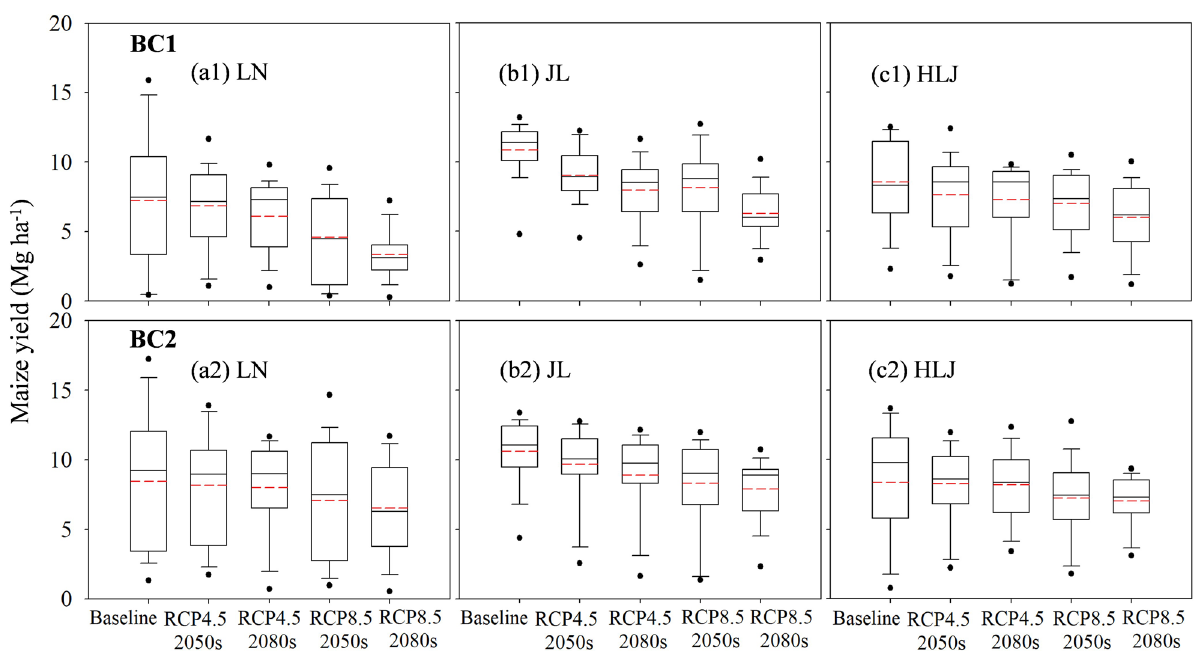
Figure 1. Effects of climate change scenarios on maize yields under BC1 ( a1 , b1 , c1 ) and BC2 ( a2 , b2 , c2 ) climate scenarios at Liaoning (LN), Jilin (JL) and Heilongjiang (HLJ) provinces in Northeast China. The black (solid) and red (dashed) lines, lower and upper edges of the boxes, and bars and dots outside the boxes represent median and mean values, 25th and 75th, 5th and 95th, and < 5th and > 95th percentiles of all data,